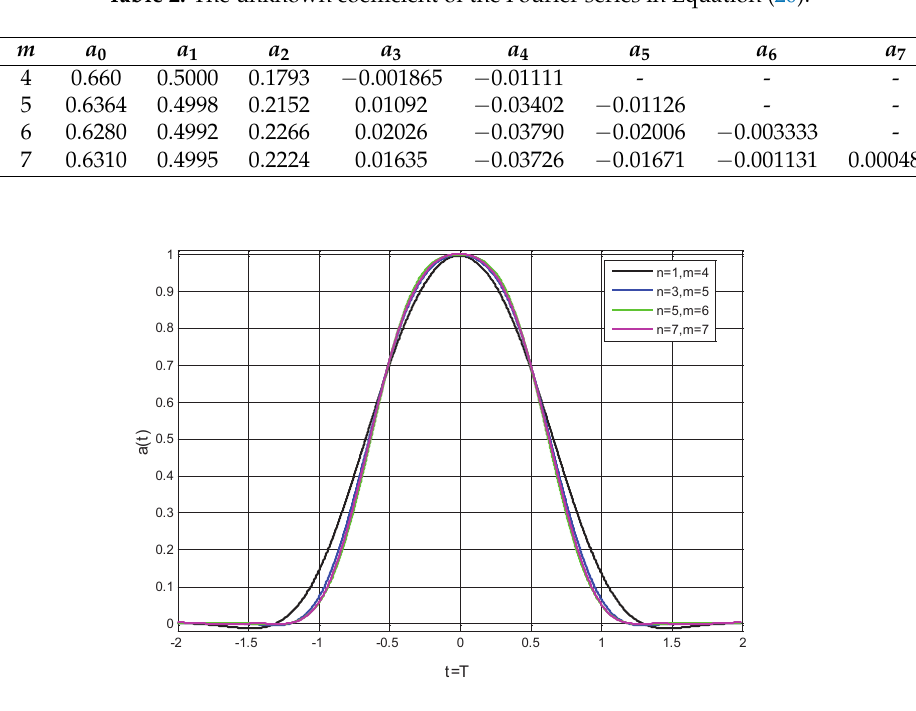
Table 2. The unknown coefficient of the Fourier series in Equation (20).